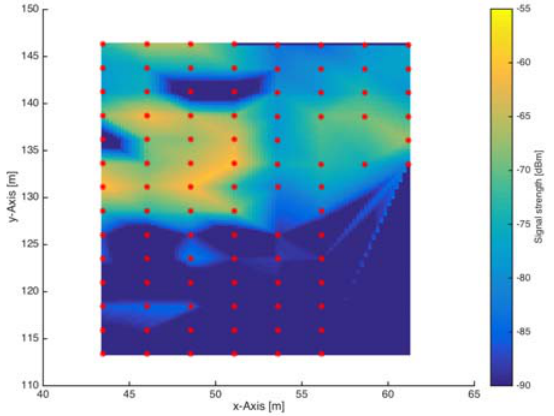
Figure 10. Radio map of AP CDEG-1 for smartphone SM2 at epoch 1